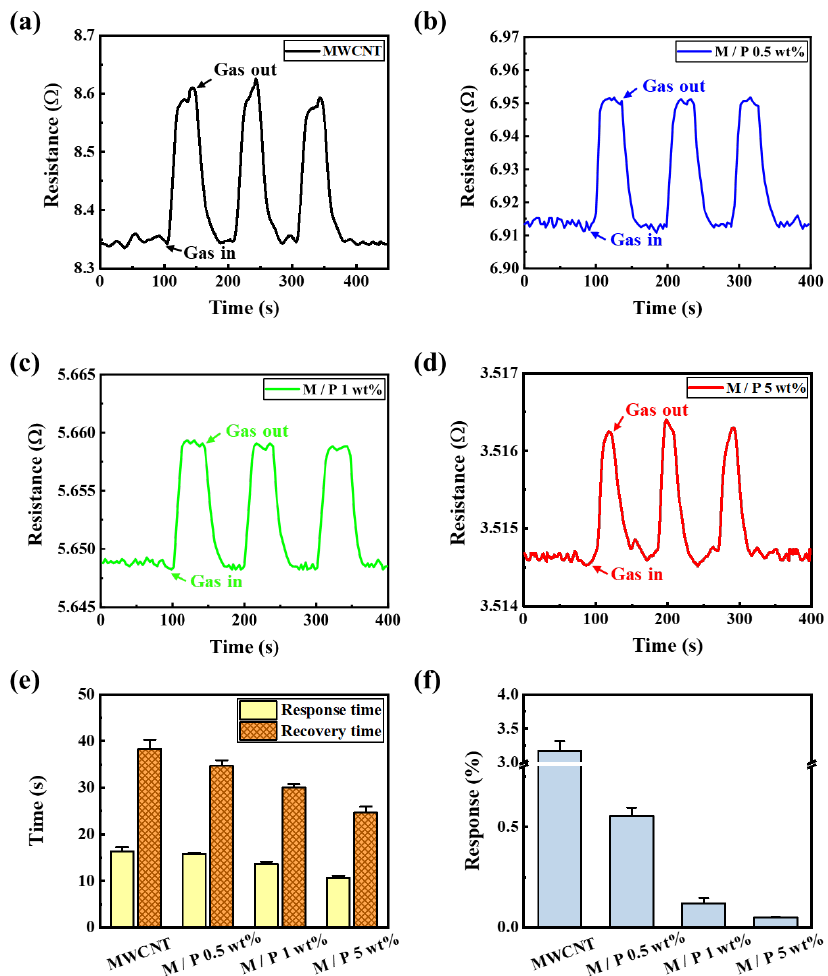
Figure 6. Response curves to 1000 ppm of CO gas for ( a ) pristine MWCNTs and ( b ) 0.5 wt% PEDOT:PSS-MWCNTs. ( c ) 1 wt% PEDOT:PSS-MWCNTs. ( d ) 5 wt% PEDOT:PSS-MWCNTs. ( e ) Response and recovery times of samples to 1000 ppm CO gas at room temperature ( f )